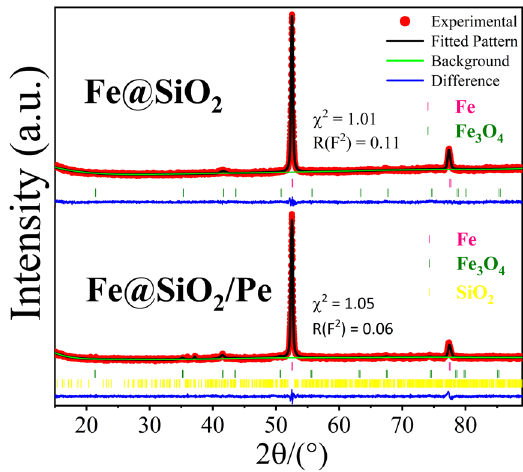
and Fe@SiO /Pe. Figure 3. Rietveld refinement XRD patterns of Fe@SiO 2 2 Fe@SiO /Pe systems. 2